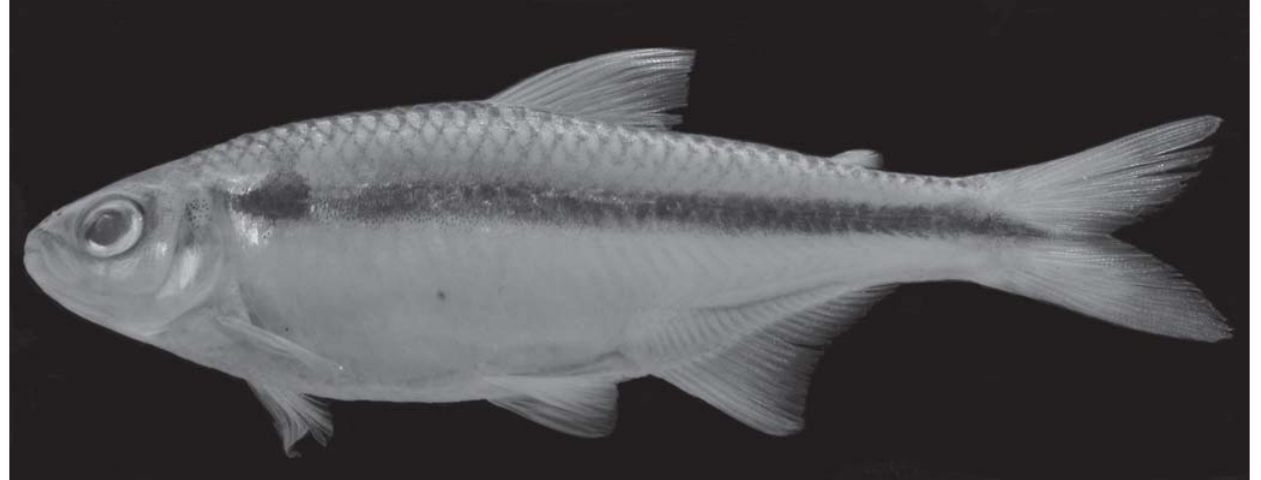
Fig. 4. Astyanax pelecus , MCP 37570, holotype, 56.4 mm SL; rio Pardo, Cândido Sales, Bahia, Brazil.